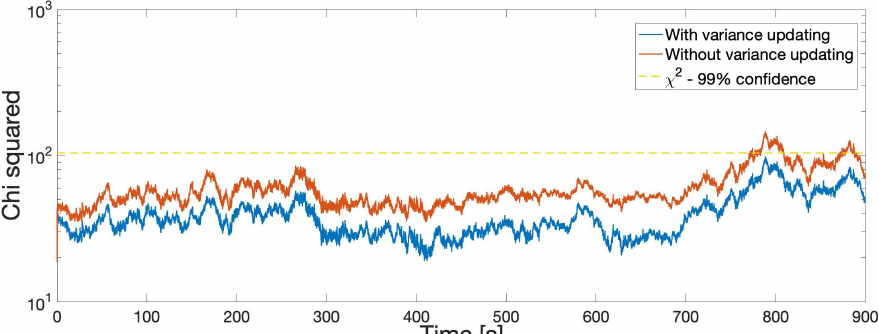
Figure 6. Comparison of Chi-Squared tests when the update of variance of measurements is applied (blue) or kept constant